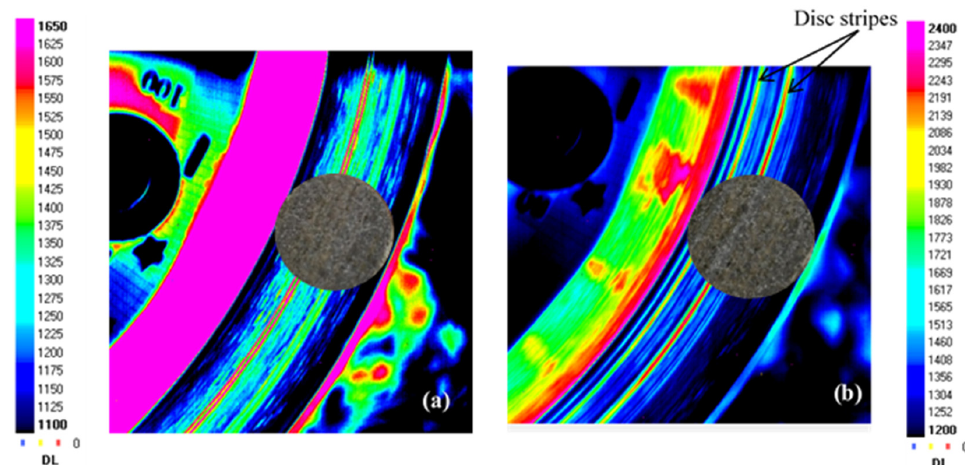
Figure 6. Infrared radiation of the same area of the disc rubbing against ( a ) FMFS and ( b ) FMFBs at the end of 5 min friction test.